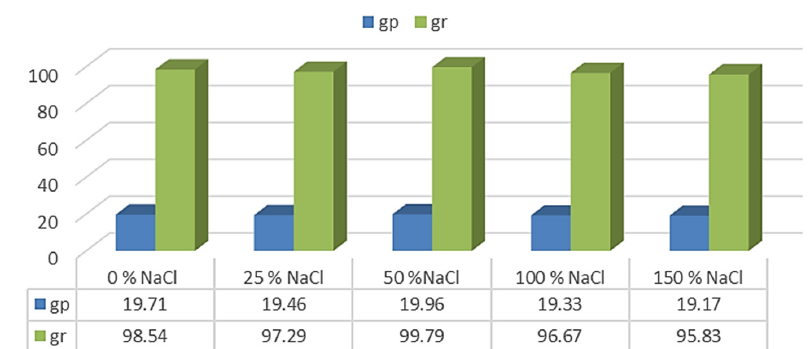
Figure 3. Effect of salt stress on germination percentage (GP) and germination rate (GR)